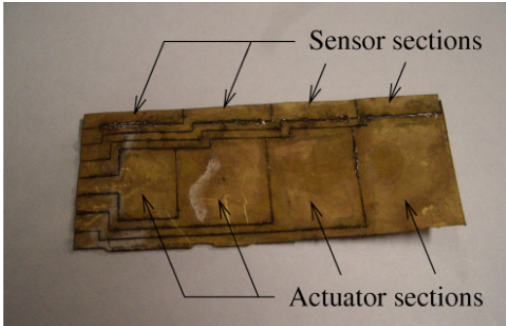
Figure 3. Sectioned IPMC with Multiple Inputs and Multiple